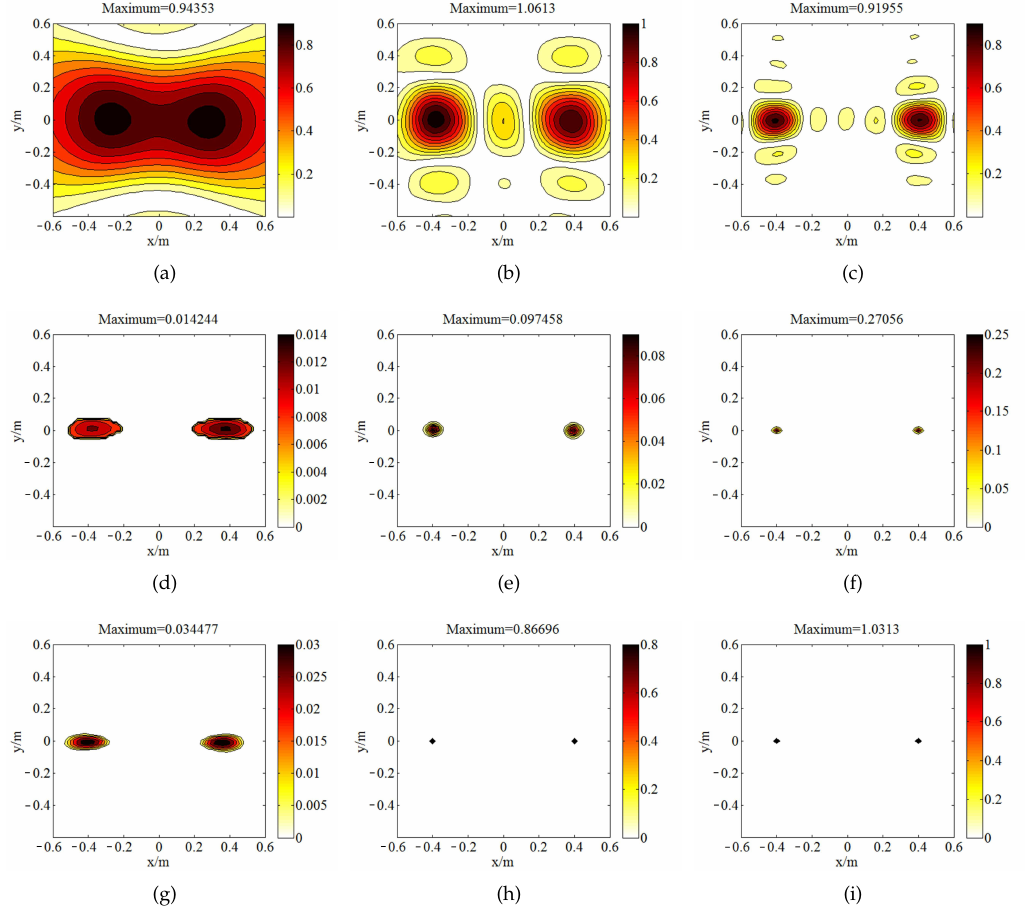
Figure 4. The comparison of sources maps (with unit of m 4 /s 2 ) in the simulation of focusing: ( a ) SOAP, 500 Hz; ( b ) SOAP, 1500 Hz; ( c ) SOAP, 3000 Hz; ( d ) (cid:96) 1 -GIB, 500 Hz; ( e ) (cid:96) 1 -GIB, 1500 Hz; ( f ) (cid:96) 1 -GIB, 3000 Hz; ( g ) BI-AI with 20 inner iterations, 500 Hz; ( h ) BI-AI with 20 inner iterations, 1500 Hz; ( i ) BI-AI with 20 inner iterations, 3000